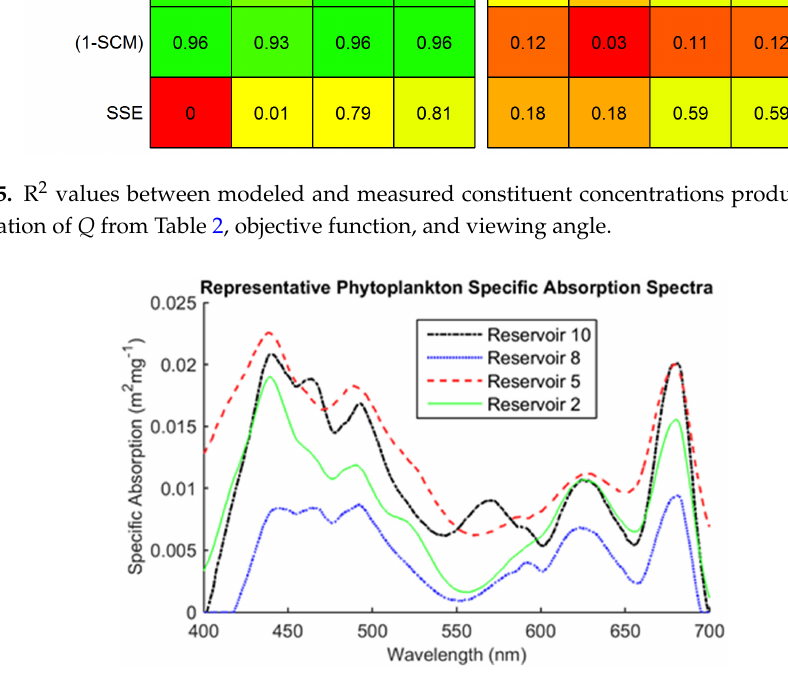
Figure 6. Representative specific absorption coefficient spectra of phytoplankton assemblages in Singapore’s reservoirs. The specific absorption coefficient measured in Reservoir 2 was chosen for our algorithm.